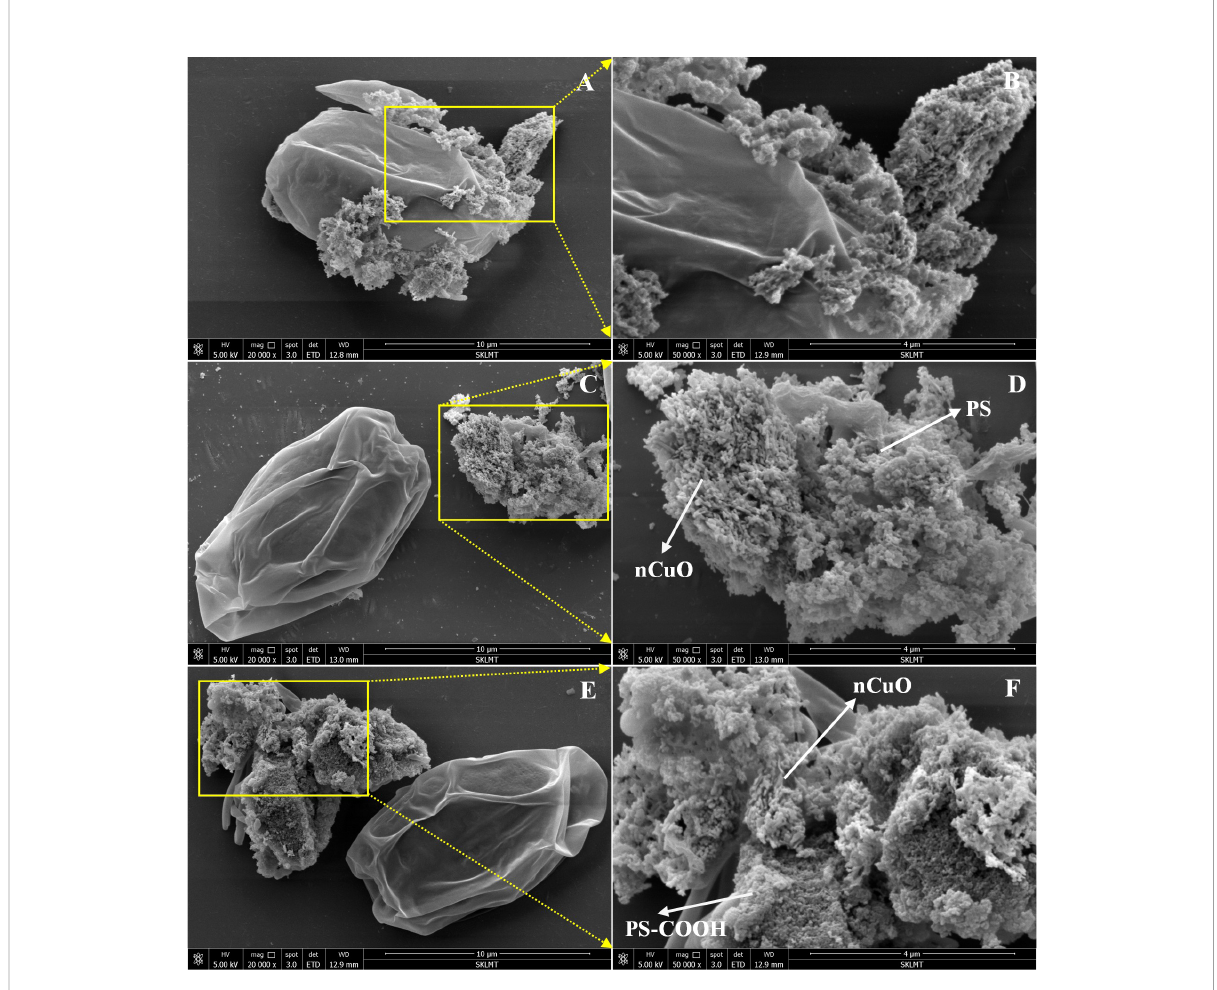
FIGURE 4 SEM images of P. helgolandica var. tsingtaoensis exposed to nCuO (A, B) , nCuO + PS (C, D) , and nCuO + PS-COOH (E, F)